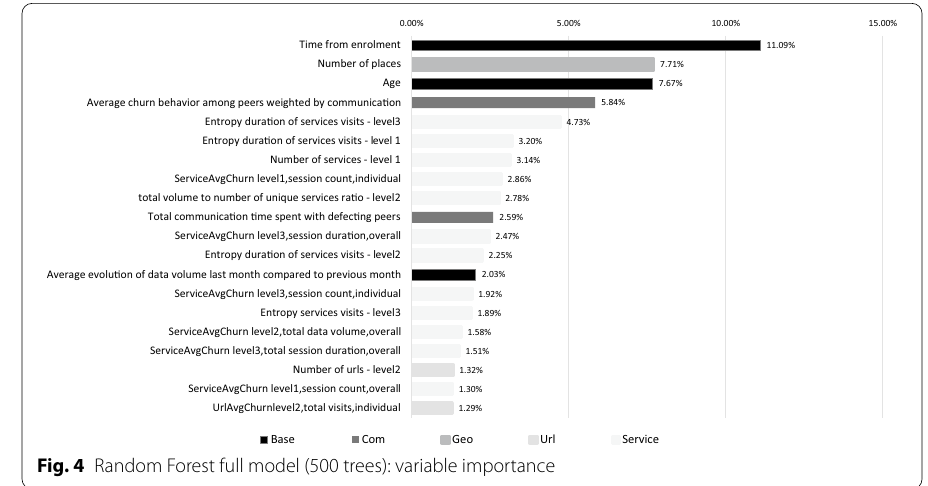
Fig. 4 Random Forest full model (500 trees): variable importance